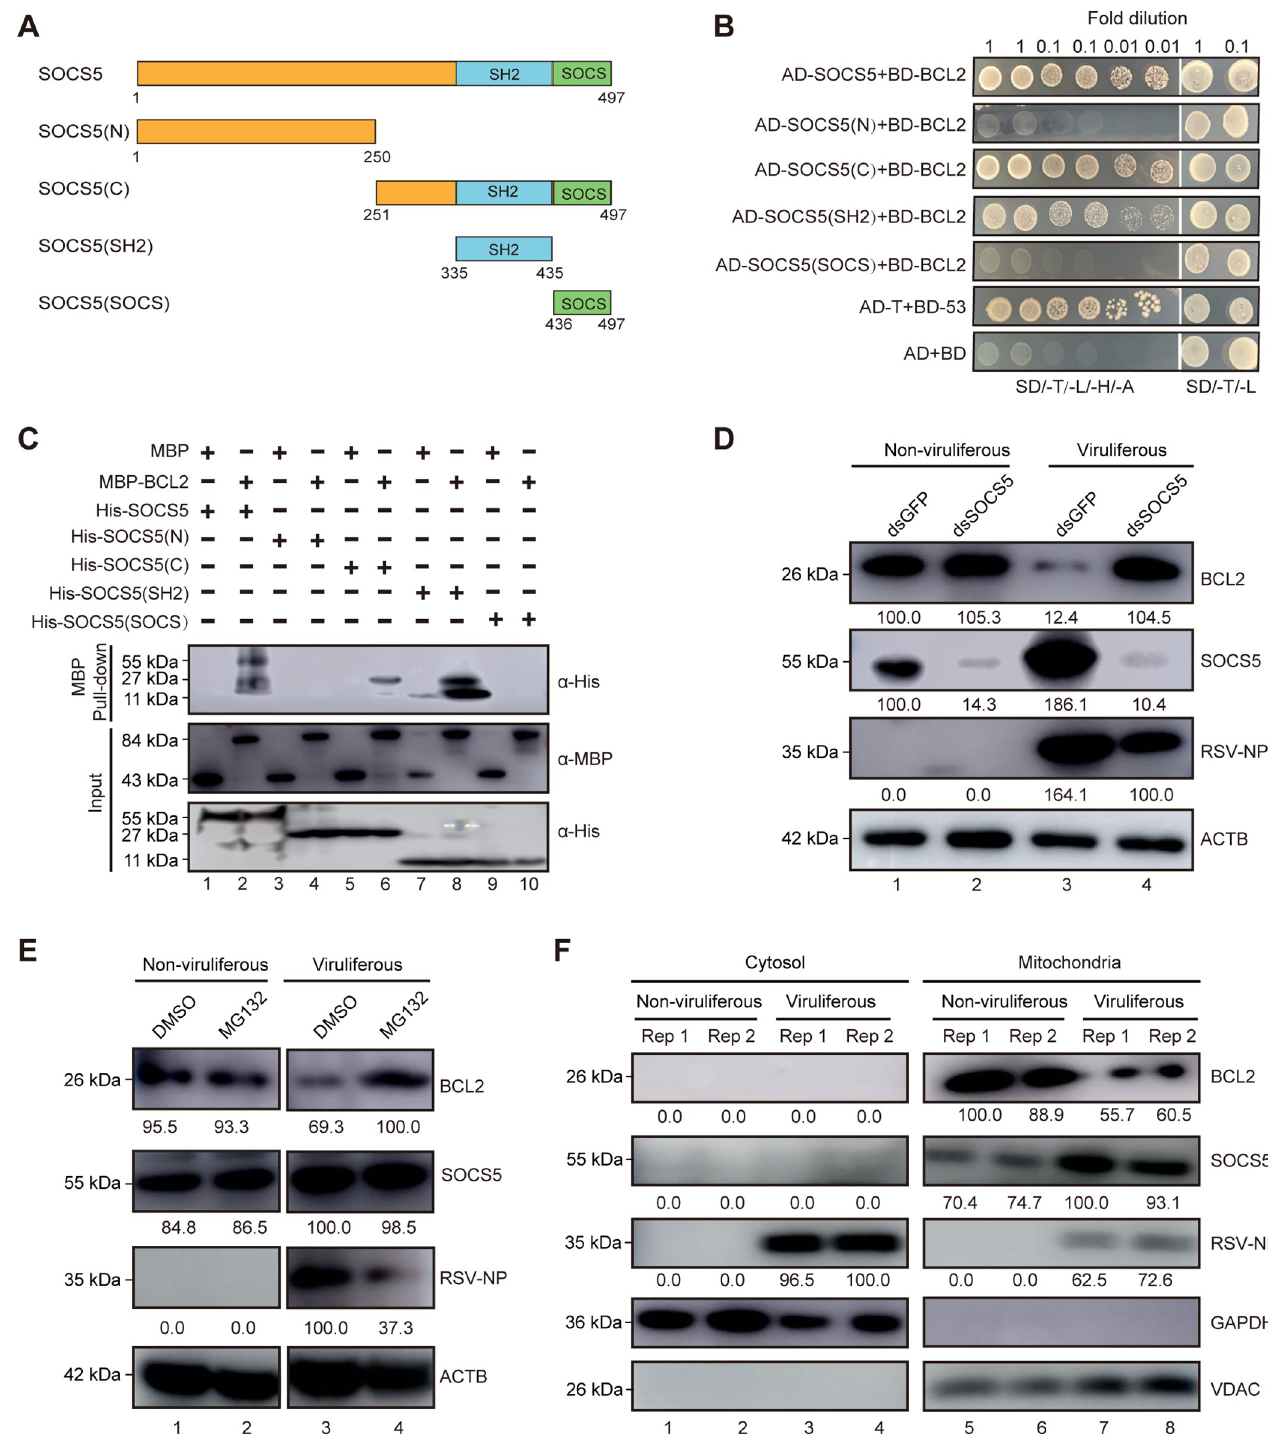
Fig 3. SOCS5 promotes the degradation of BCL2 during viral infection. (A) Structure feature of full-length and four fragments of SOCS5. (B) SH2 domain of SOCS5 specifically interacted with BCL2 as detected by yeast two-hybrid assay. The co-transformed AH109 yeast cells with 10-fold serial dilutions were plated on synthetic dextrose (SD) lacking tryptophan, leucine, histidine, and adenine (SD/-T/-L/-H/-A) or SD/-T/-L medium to analyze positive interactions. Yeast cells co-transformed with AD-T+BD-53 served as a positive control. Yeast co-transformed with AD+BD acted as a negative control. (C) MBP pull-down assay of the interaction between SOCS5 and BCL2. MBP, MBP-BCL2, full-length and fragments of His-SOCS5 were expressed and purified from the E . coli . The purified MBP or MBP-BCL2 was individually mixed with full-length and four fragments of His-SOCS5 and pulled down with MBP beads. MBP-BCL2